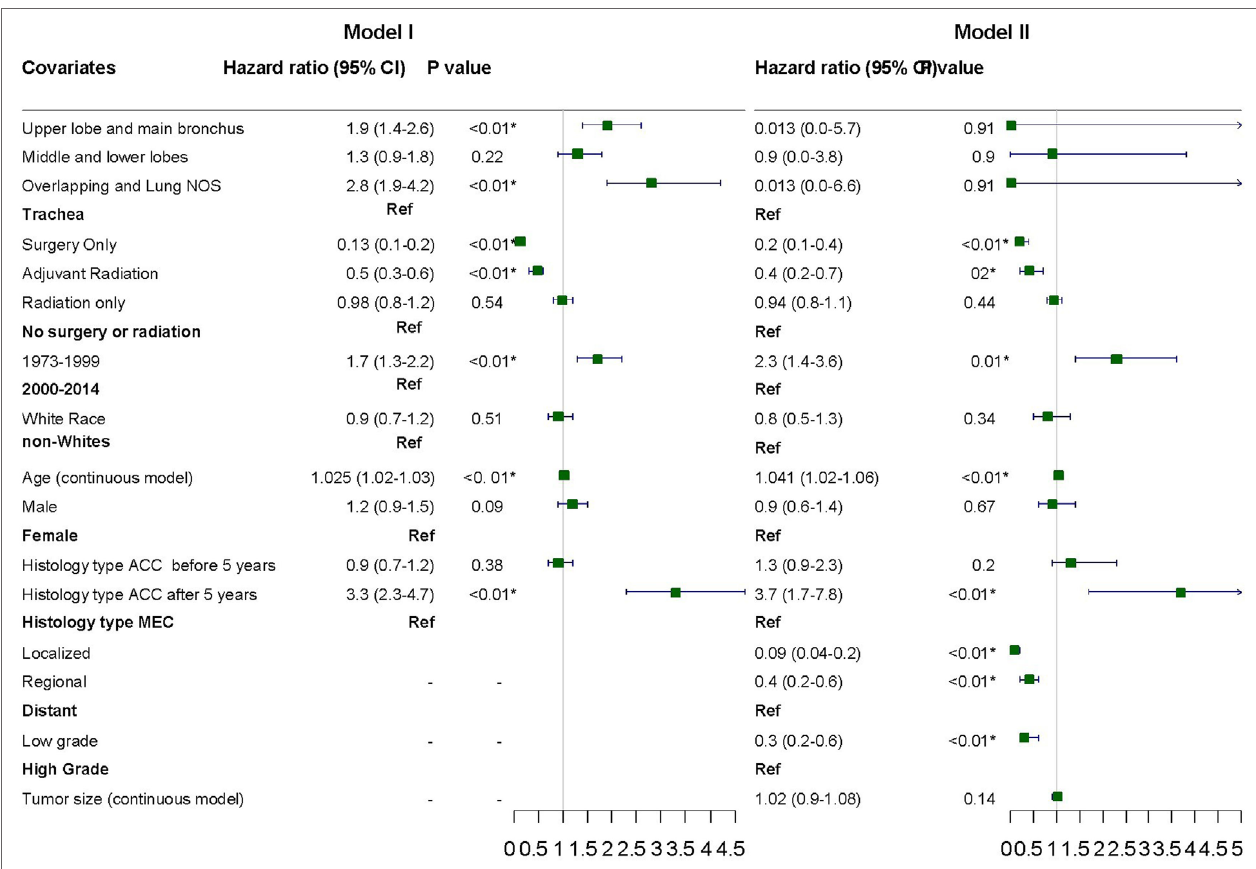
FigUre 5 | Hazard ratios with 95% confidence intervals for predictors of adverse outcome on cox proportional hazard